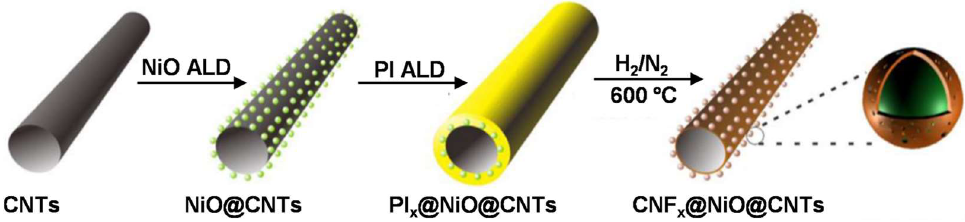
Figure 9. Schematic illustration for the synthesis procedure of a CNF x @Ni@CNTs catalyst. Adapted with permission from ref [103]. Copyright 2017 American Chemical Society .